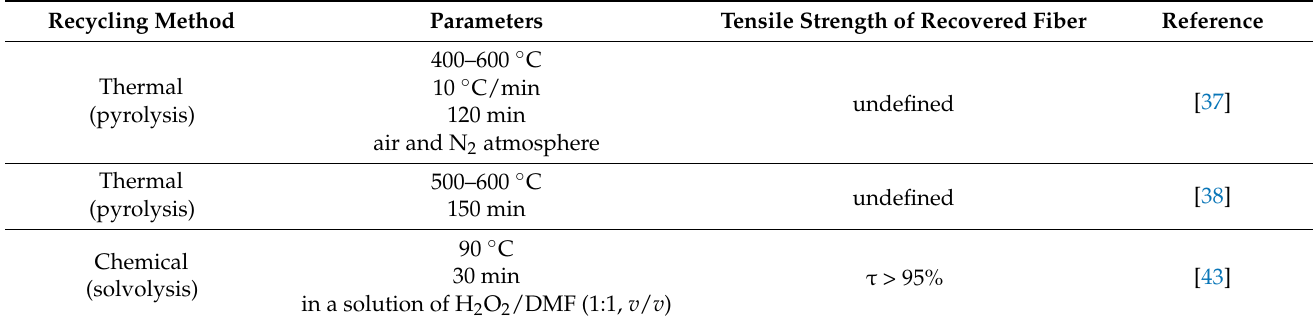
Table 2. Literature summary on most used composite recycling